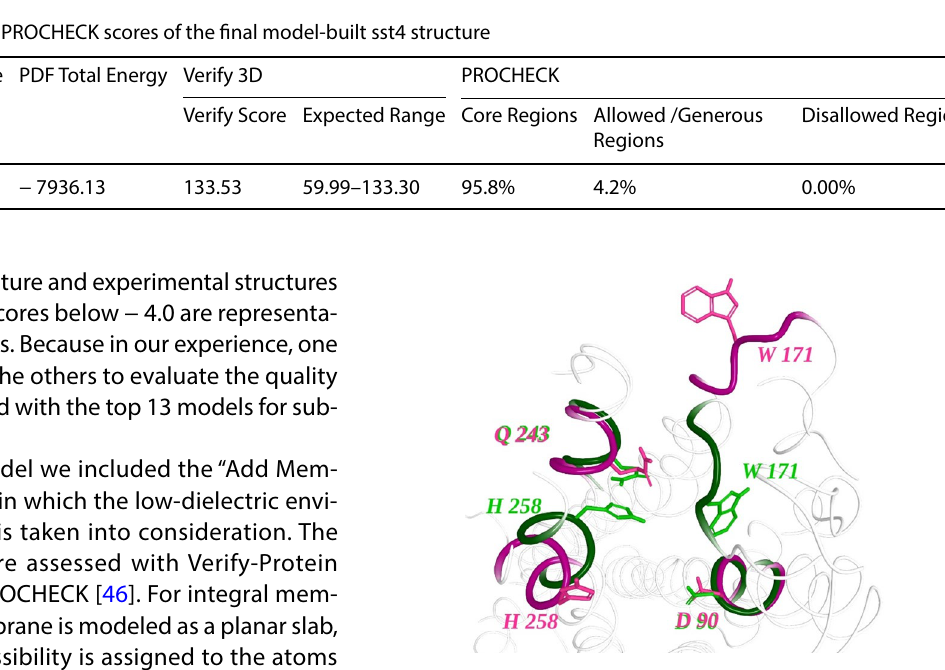
Fig. 4 Depiction of the different location of critical amino acids in an overlay of our previously reported model-built sst (green, based on the beta-2 adrenergic receptor) onto the model constructed in the present work (purple, based on the mu-opioid crystal